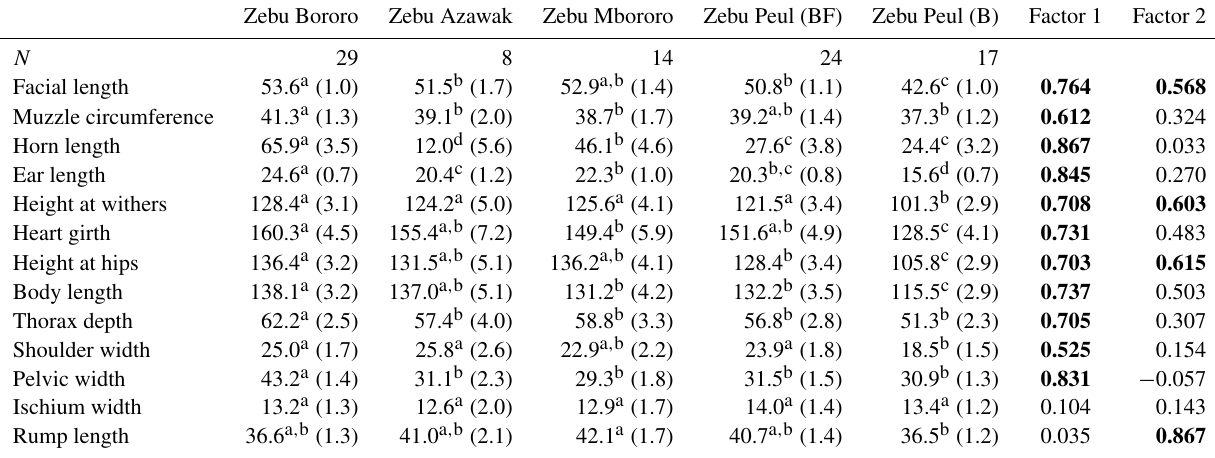
Table 2. Least squares means (in cm) and their standard errors (in brackets) for 13 body measurements assessed in sires belonging to five West African zebu cattle breeds. Results and sample size ( N ) are given per breed. Eigenvectors computed for two factors identified via principal component analysis (eigenvalues > 1) are also given. Eigenvectors higher than | 0.510 | are in bold. Factor 1 explains 61.88% of the total variability. Factor 2 explains 8.21% of the total variability. Different superscripts denote significantly different trait raw means at p < 0.05. “(BF)” and “(B)” mean Burkina Faso and Benin,